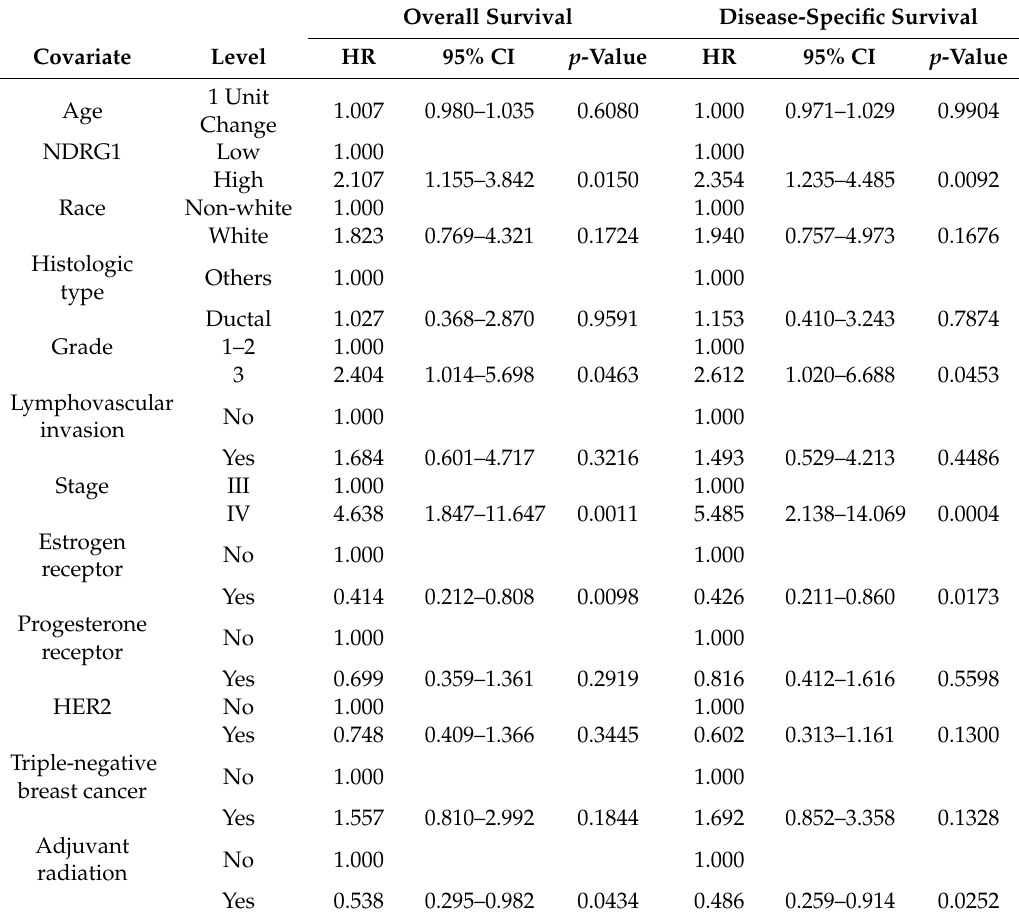
Table 2. Univariate Cox regression analysis on overall survival and disease-specific survival among patients with